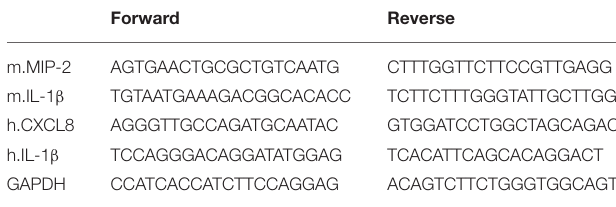
TABLE 1 | RT-PCR primer